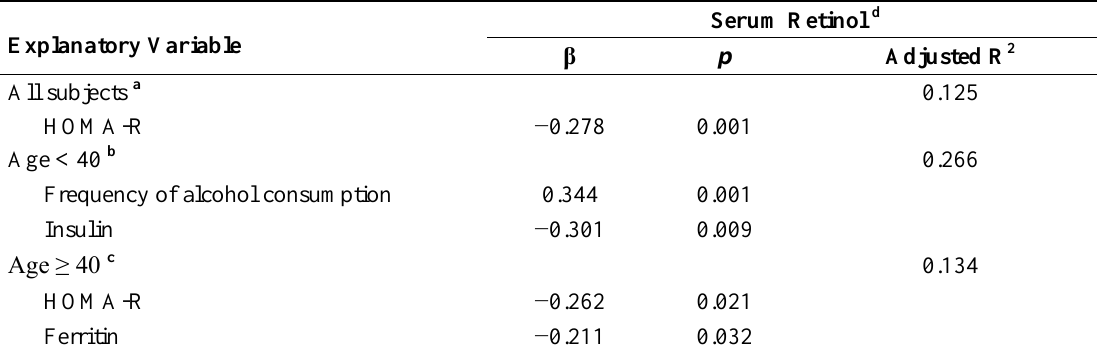
Table 4. Multiple regression analysis of serum retinol with each parameter.